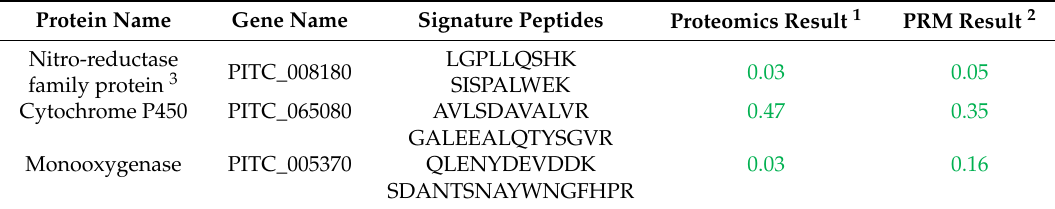
Table 5. Comparison of the proteomics result and the PRM result of the three candidate